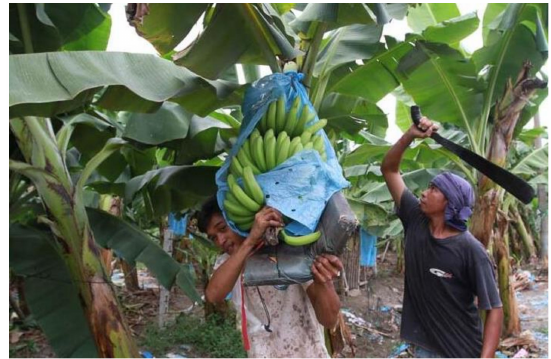
Figure 1. Workers are picking a banana